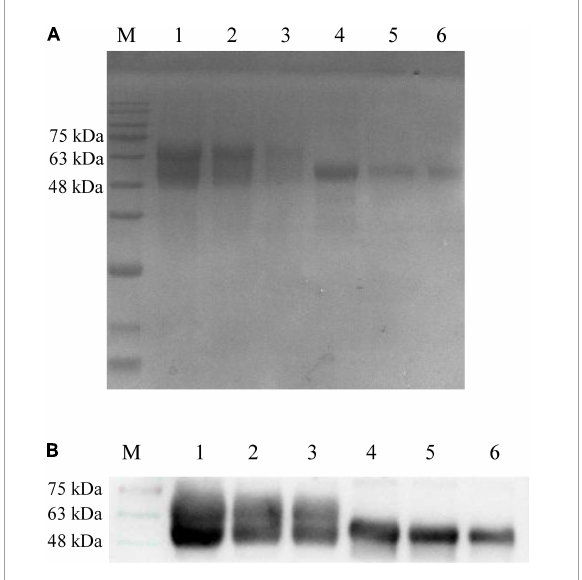
FIGURE1 Detection of recombinant proteins gB and gD by SDS-PAGE (A) and Western blot (B) . (A) The culture supernatant of sf9 cells was harvested and purified using a Ni column. The purified recombinant proteins gB and gD were diluted with PBS and mixed with 4 × loading buffer to conduct SDS-PAGE. M: Solarbio 180 Marker. 1: gB (1,500 µ g/mL), 2: gB (750 µ g/mL), 3: gB (375 µ g/mL), 4: gD (300 µ g/mL), 5: gD (150 µ g/mL), 6: gD (75 µ g/mL). (B) PRV-positive serum (collected by our laboratory,